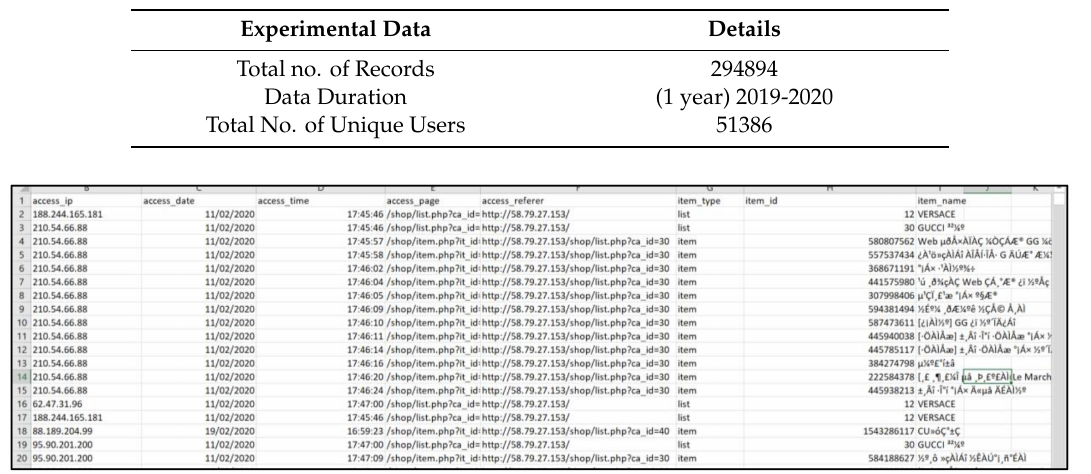
Table 3. Characteristics of data used for experiments.